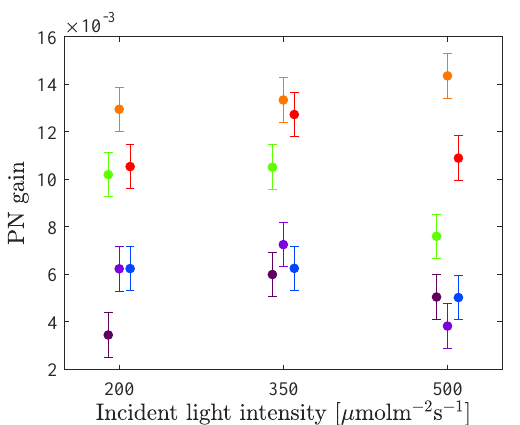
Figure 10. Photosynthetic rate gains vs. incident light intensity for cucumber (set B). Mean values of PN gains and one standard error of the mean are depicted. Note that different leaves have been used for the different intensity levels.